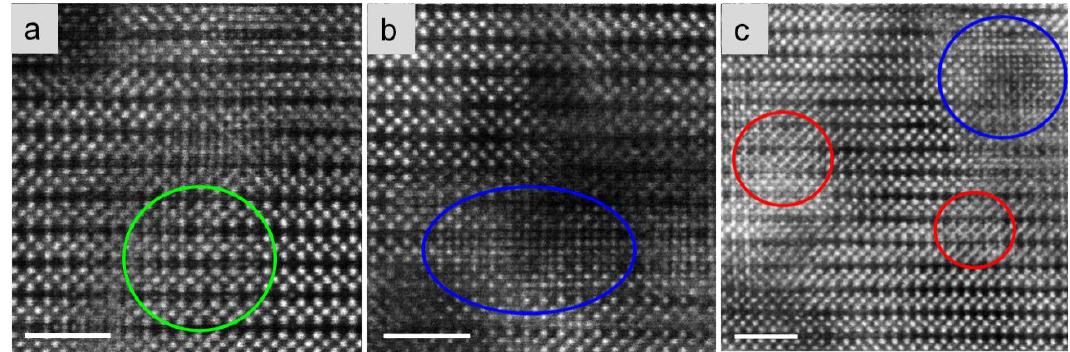
Figure 4. ( a – c ) The diverse defects formed in the 1000 °C-quenched electrolytes containing many intermediate defects, highlighted by ellipses in different colours. Scale bars: 2 nm. highlighted by ellipses in different colours. Scale bars: 2